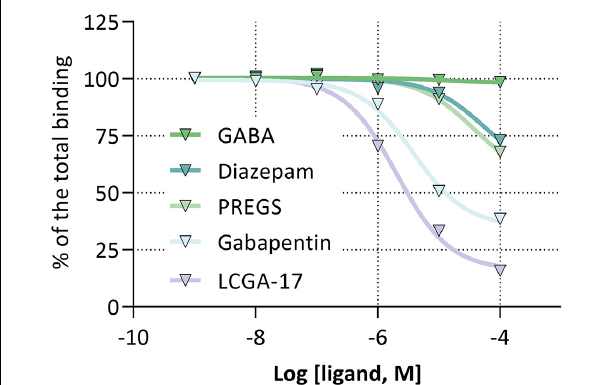
FIGURE 3 | Competition of [ 3 H]-LCGA-17 binding to cortical membranes by high-affinity ligands of the GABA A R BZD and neurosteroid binding sites and the gabapentinoid binding pocket of α 2 δ . The fraction of [ 3 H]-LCGA-17 bound is plotted as a function of the log (ligand, M). IC 50 : gabapentin, ∼ 11 µ M; LCGA-17, ∼ 2 µ M; GABA, diazepam, and PREGS, > 100 µ